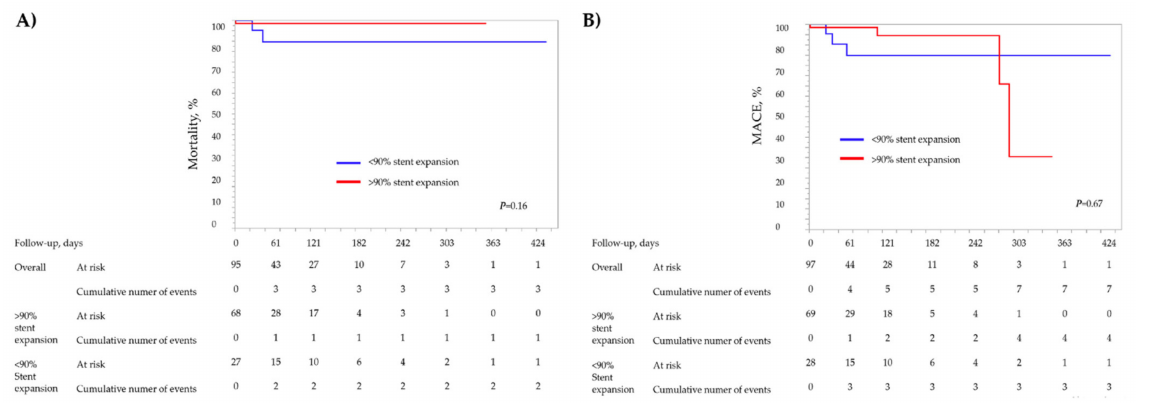
Figure 1. Kaplan–Maier survival estimates of mortality and MACE occurrence during follow- up period according to the stent expansion. ( A ) Kaplan–Meier survival estimates for mortality. ( B ) Kaplan–Meier survival estimates for